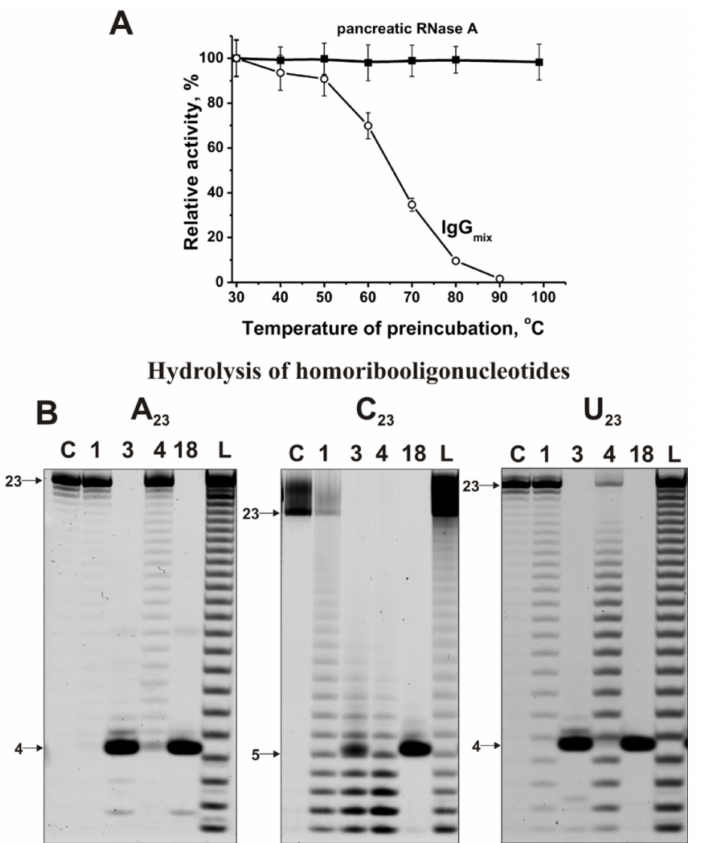
Figure 2. Comparison of thermal stability of IgG mix and human RNase A ( A ). IgG mix and RNase A were incubated for 15 min at different temperatures, and then their relative RNase activities were es- timated using miR-137. The patterns of 5’-Flu-(pA) 23 , 5’-Flu-(pC) 23 , and 5’-Flu-(pU) 23 (0.01 mg/mL) splitting by IgGs (0.6 µ M IgGs; 1 h of incubation) from sera of four different MS patients ( B ). The prod- ucts of the cleavage were detected due to the fluorescent residue (Flu) on their 5 (cid:48) -ends. The lengths of the products, numbers of antibodies, and homo-oligonucleotides used are indicated in panel ( B